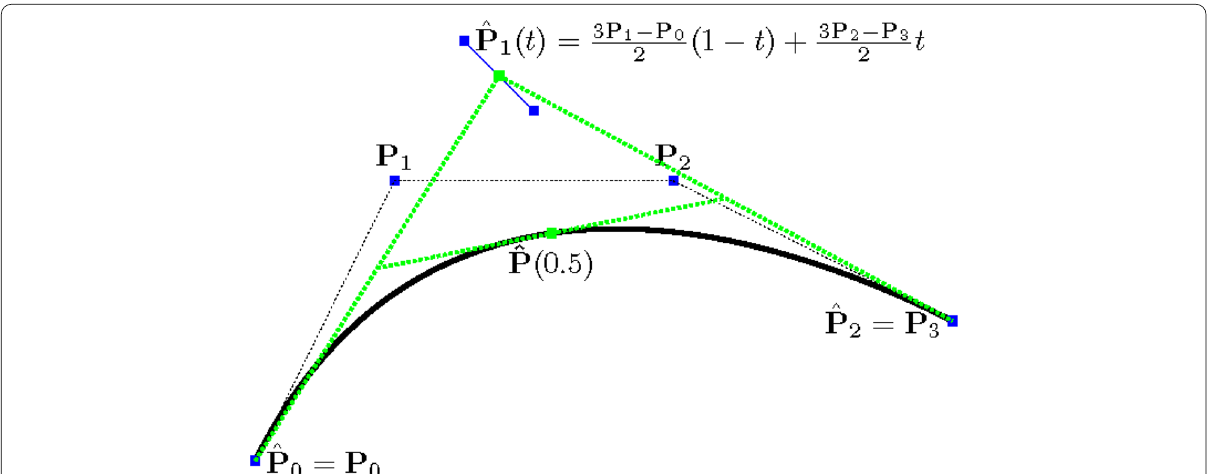
Fig. 1 A cubic Bézier curve expressed as a quadratic hybrid